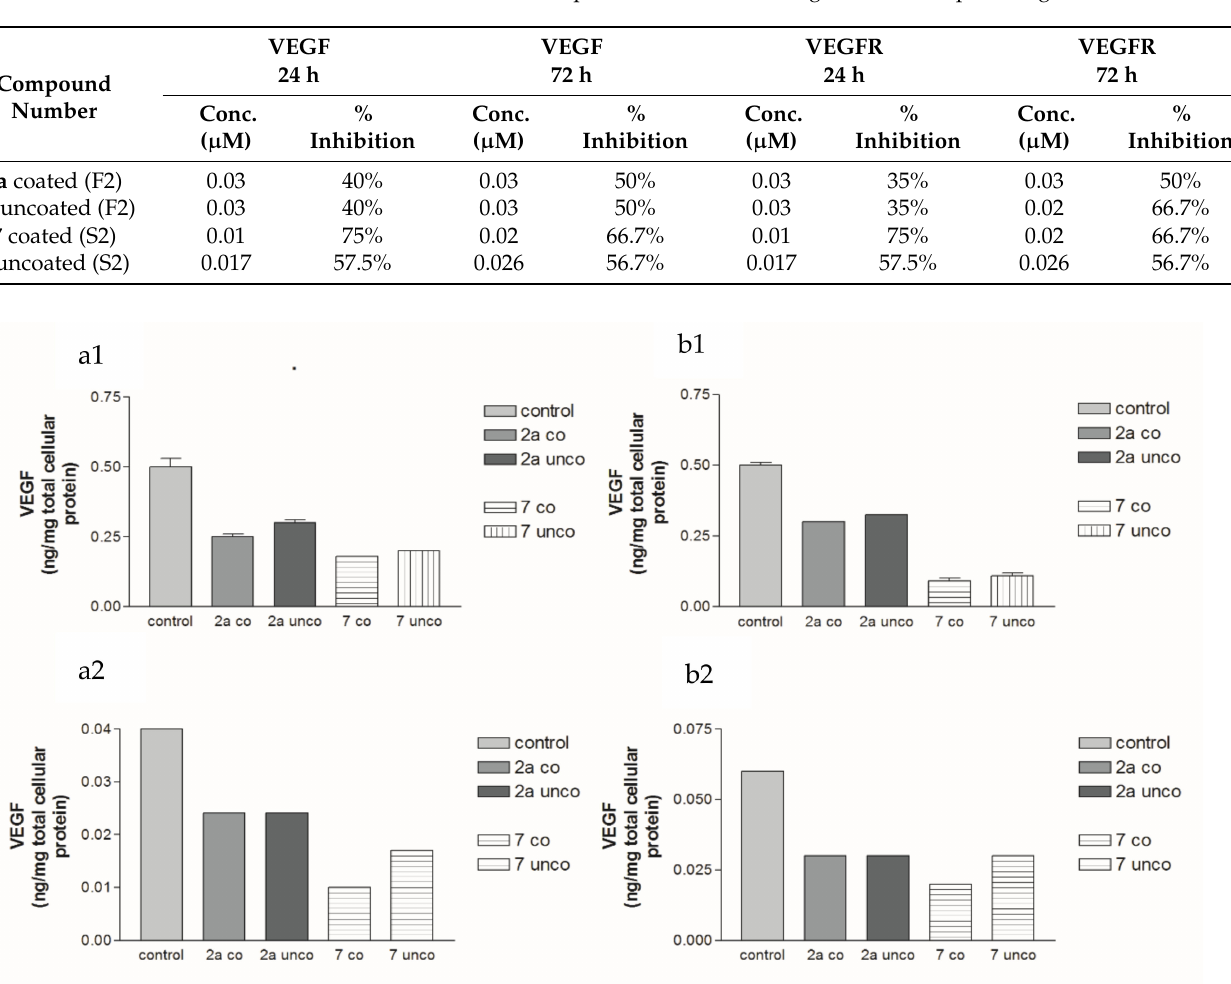
Table 11. Effects of 2a - and 7 -loaded niosomes (F2 and S2) either coated with TPGS versus the uncoated ones in the MCF-7 cell line compared to the control using ELISA as the percentage of inhibition.